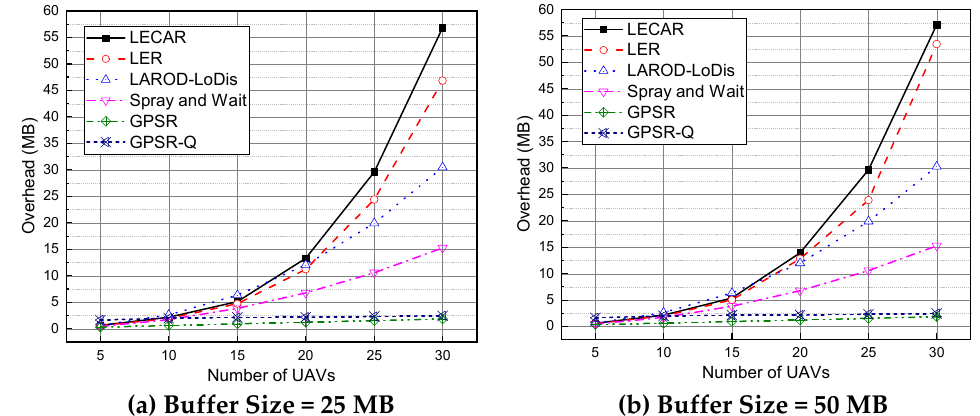
Figure 16. Performance comparison of the considered routing protocols regarding overhead when the buffer size is ( a ) 25 MB and ( b ) 50 MB.